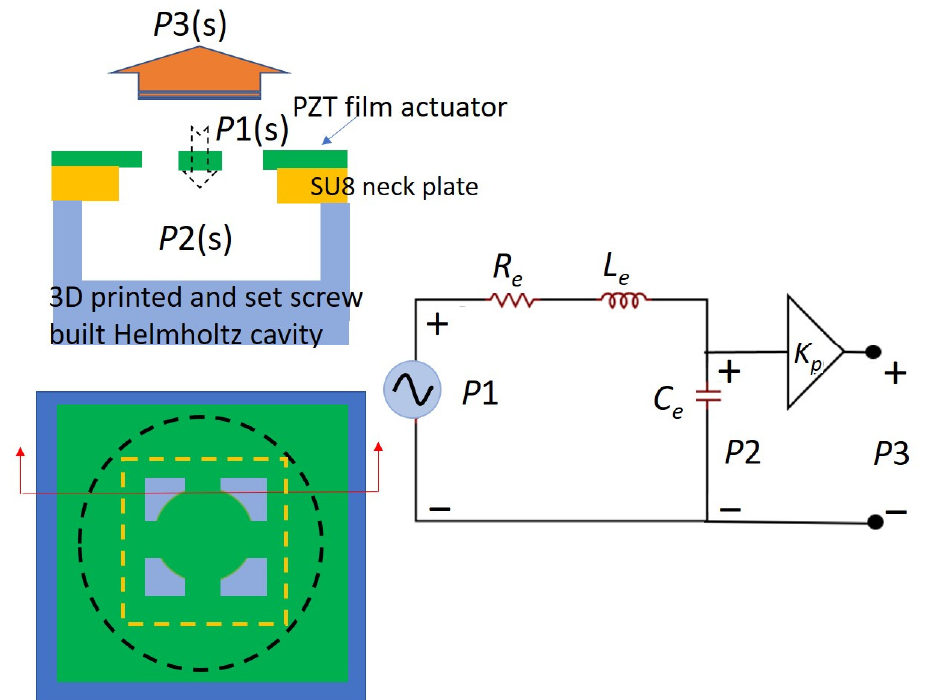
Figure 15. The proposed modified Helmholtz resonator circuit to characterize our experimental results.